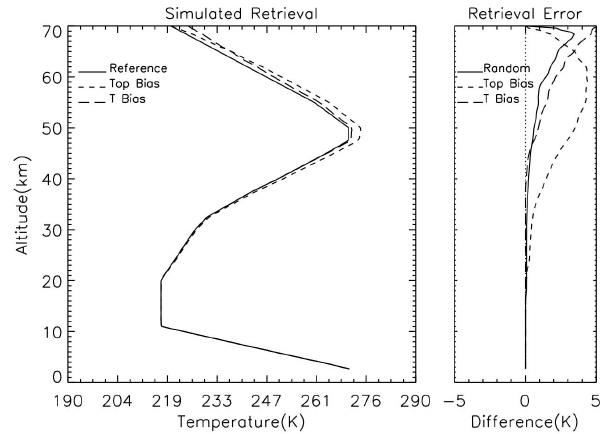
Fig. 24. Same as Fig. 23 but retrieved CO 2 mixing ratio profile. Fig. 25. Impact of random pointing errors and top boundary errors on retrieved temperature, long dashed line shows impact of 5K up- per boundary temperature error, short dashed lines shows impact of 5% upper boundary error on refraction angle. Right-hand panel shows the errors, solid line in right-hand panel shows impact of ran- dom pointing error of